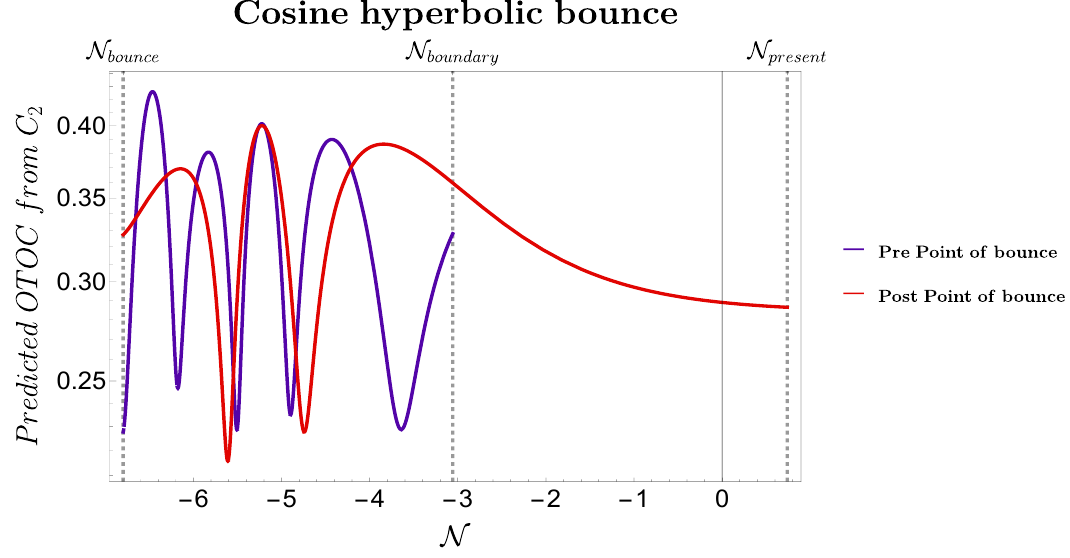
Figure 24: Predicted OTOC from geodesically weighted complexity inside bouncing region with respect to number of